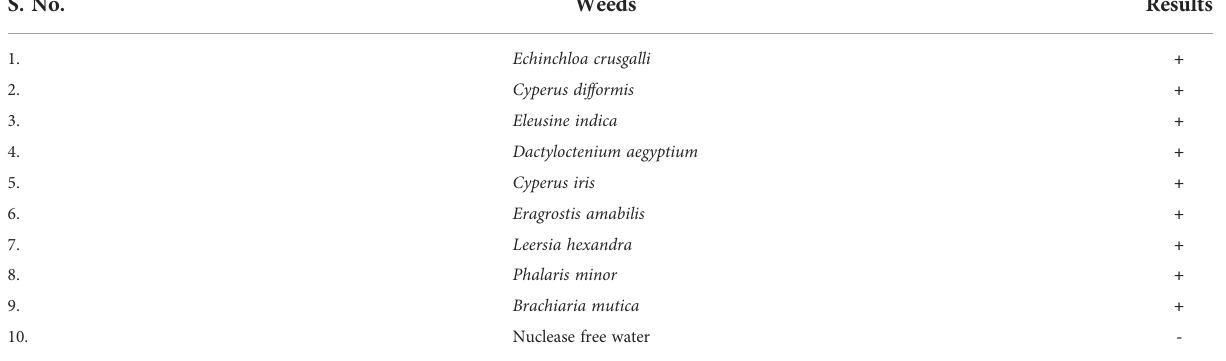
TABLE 6 Validation of LAMP with weeds collected from paddy fi elds. S. No.